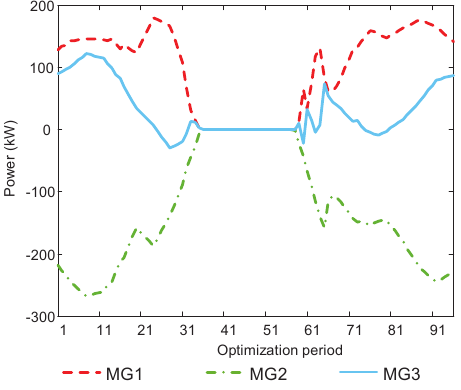
Figure 23. Decided exchange power among MGs in Scenario 2.